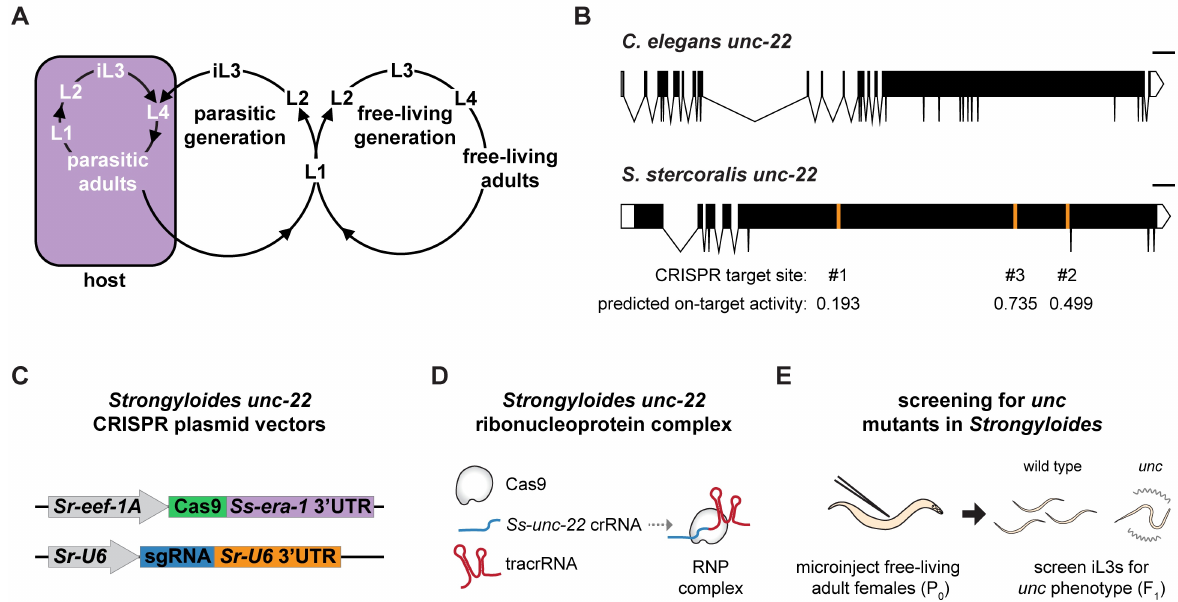
Fig 1. A strategyfor targeted mutagenesis in S . stercoralis using CRISPR-Cas9. ( A ) The life cycle of S . stercoralis . iL3s enter hosts by skin penetration.The nematodes then developinto parasitic adults, which reside and reproduce in the small intestine. Their progeny exit the host in feces and developinto either iL3s or free-livingadults. The free-livingadults mate and reproduce in the environment, and all of their progenydevelopinto iL3s. Thus, S . stercoralis can developthrough a single generation outside the host [10]. S . stercoralis can also completeits life cycle within a singlehost [9]. L1-L4 = 1 st -4 th larval stages. Adapted from Gang and Hallem, 2016[10]. ( B ) The unc- 22 genes of C . elegans and S . stercoralis . The Ss-unc-22 gene structure depicted is basedon the gene prediction from WormBase ParaSite [24,47].The CRISPR target sites tested and their predicted on-target activity scores are indicated[50]. Scale bar = 1 kb. ( C ) Plasmidvectors for the expressionof Cas9 and sgRNA in S . stercoralis . ( D ) RNP complex assembly. Cas9 protein, crRNA targeting Ss- unc-22 , and tracrRNA are incubated in vitro to form RNP complexes [20]. ( E ) Strategy for targeted mutagenesis in S . stercoralis . Plasmid vectors or RNP complexeswere introduced into developingeggs by gonadalmicroinjection of free-living adult females. F 1 iL3 progeny were screenedfor unc phenotypes, putativelyresultingfrom mutation of Ss-unc-22 .